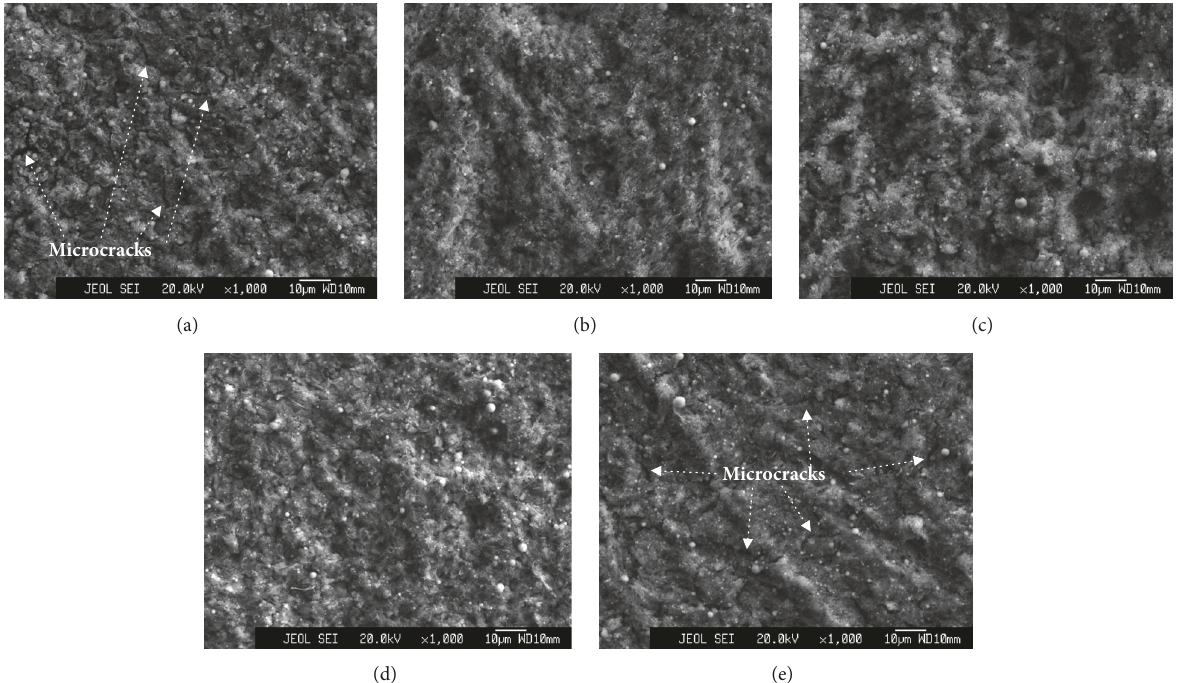
Figure 12: Morphology of the welded metals with different REE contents: (a) REE-free, (b) 0.3 wt.%, (c) 0.5 wt.%, (d) 0.7 wt.%, and (e) 1.0 wt.%, after electrochemical